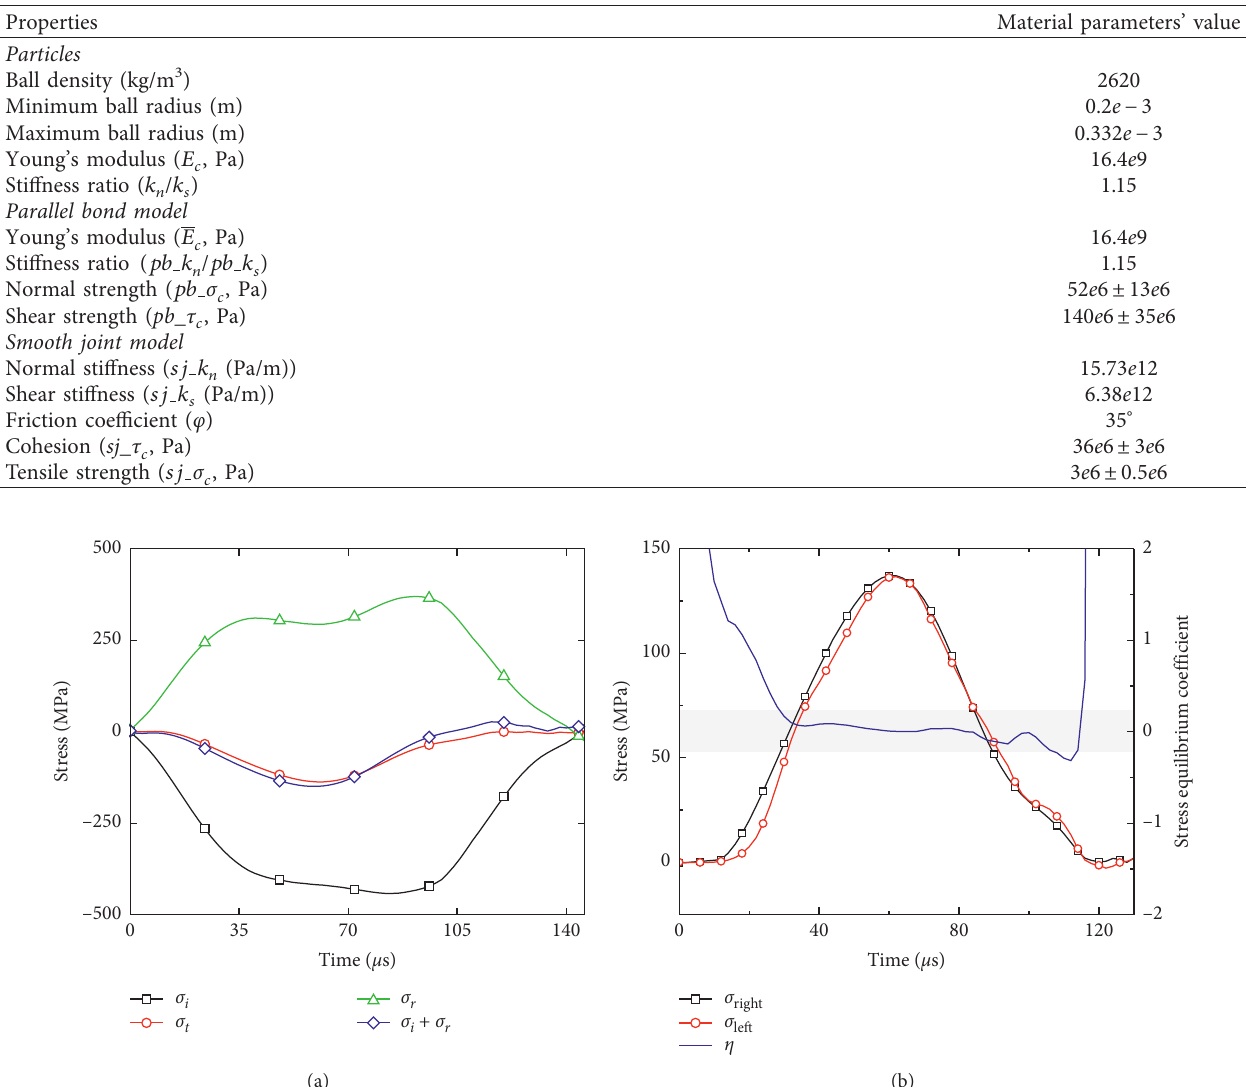
Table 3: Microscopic properties of particles and bonds of the sample.